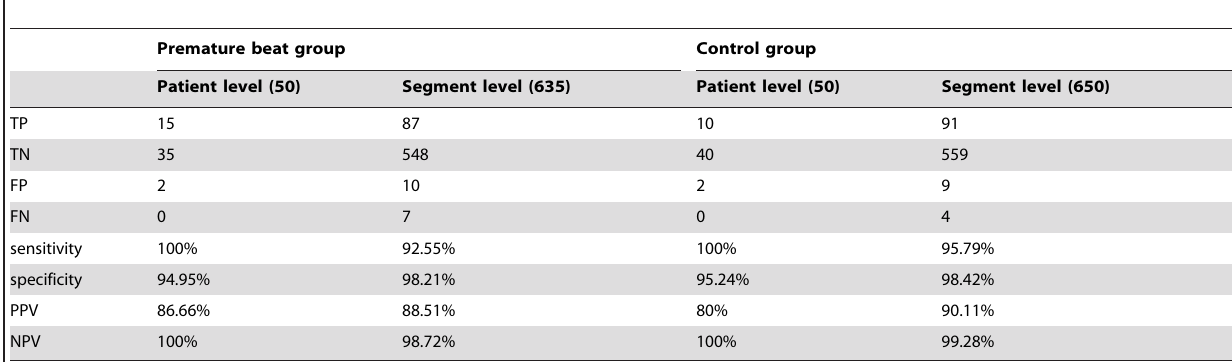
Table 3. Coronary artery stenosis diagnosis accuracy in the premature beat group and the control group.